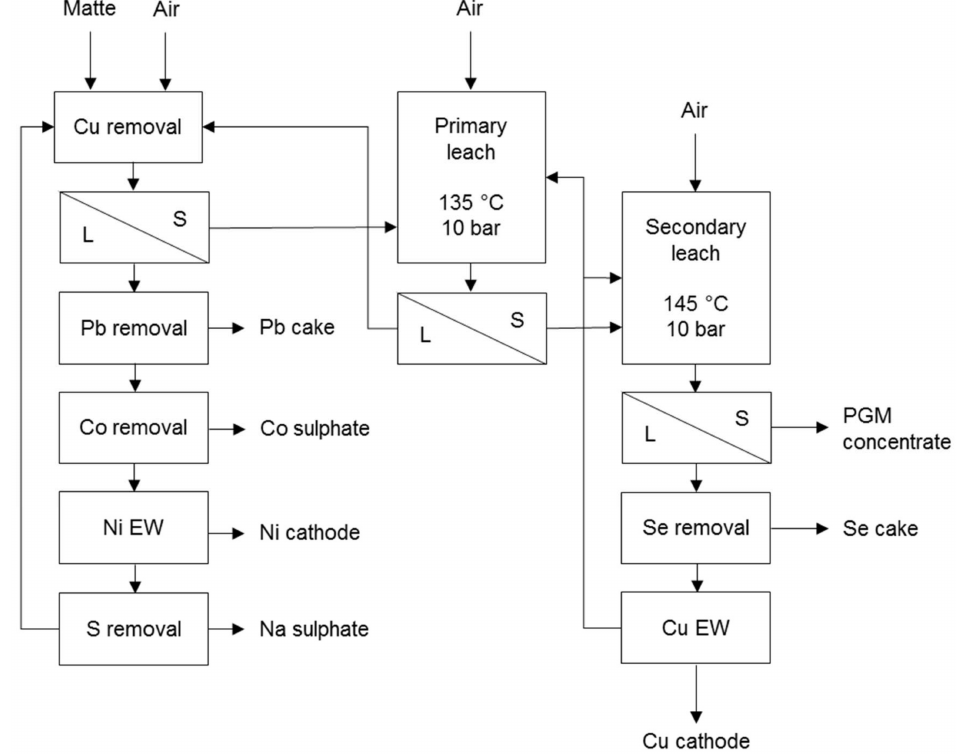
Figure 2. Simplified flow sheet of Rustenburg Base Metals Refinery (adapted from Hofirek & Halton [20]).